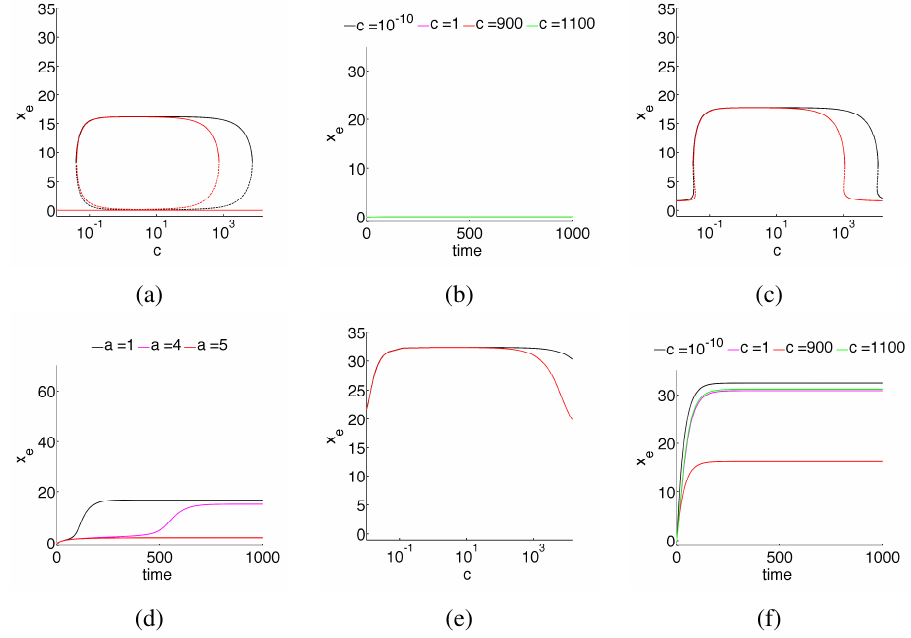
Fig. 4: Influences on LuxI and LuxR simultaneously. (a) Bifurcation diagram for the extracellular AHL- concentration, where the effect of cAMP on the competitive inhibition of the LuxI-production and the increase of the LuxR-production is considered. The basal LuxI-production rate α l is 0 . 001 . Affinity of cAMP to the lux operon compared to the AHL-LuxR dimer is assumed to be equal. This is achieved by setting b = 1 (black line) or by assuming the affinity of cAMP to the lux operon to be stronger compared to the AHL-LuxR dimer by setting b = 10 (red line). (b) Time courses for the extracellular AHL-concentration, which were generated by cells with different cAMP-concentrations. Those time courses correspond to the bifurcation diagram shown in (a), with b = 1 and α l = 0 . 001 . (c) Same figure as seen in (a), only the basal LuxI-production rate is increased to 0 . 1 . (d) Time courses for the extracellular AHL-concentration, which were generated by cells with different cAMP-concentrations. Those time courses correspond to the bifurcation diagram shown in (c), with b = 1 and α l = 0 . 1 . (e) Same figure as seen in (a), only α l = 1 . (f) Time courses for the extracellular AHL-concentration, which were generated by cells with different concentrations of regulator n l . Those time courses correspond to the bifurcation diagram shown in (e), with b = 1 and α l =